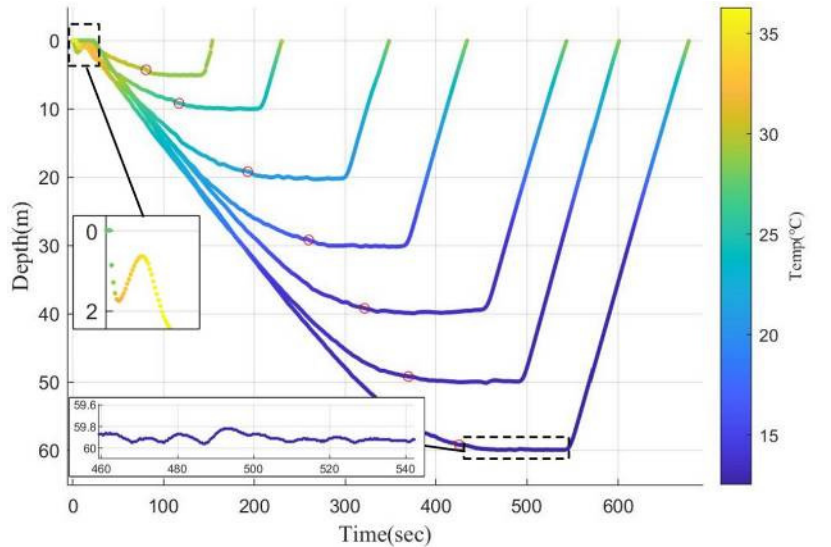
Figure 7. Using the segment PD control method to maintain the float at different depths in Qiandao Lake.